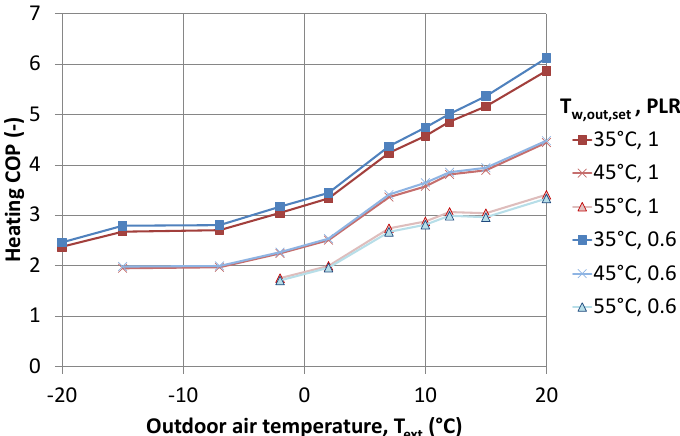
Figure 4. Heating COP simulation (lines) and catalogue (dots) data.